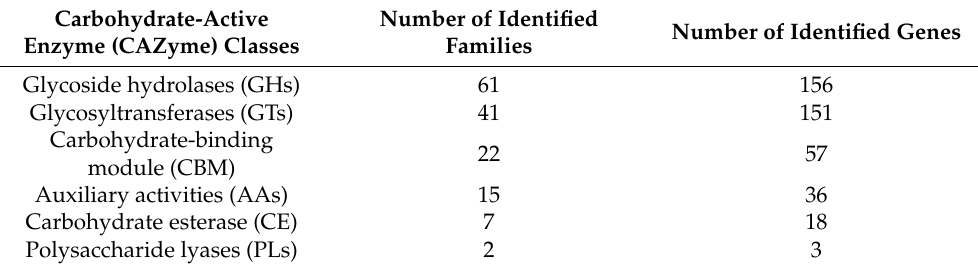
Table 3. Carbohydrate-active enzyme (CAZyme) content in the C. keratinophilum